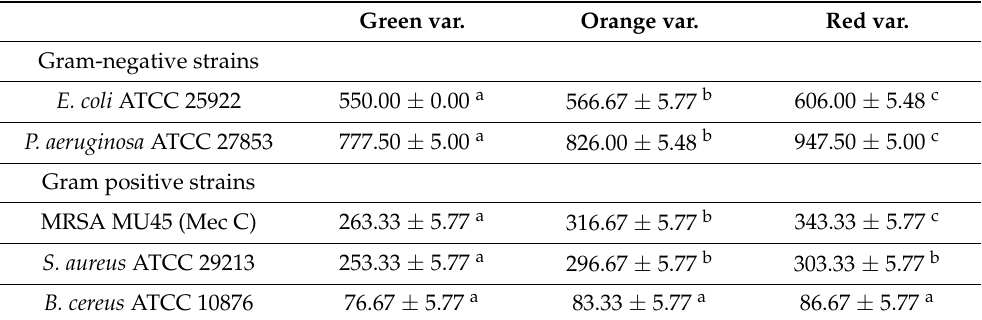
Table 3. Minimal inhibitory Concentrations of Opuntia ficus-indica root lipophilics expressed in ( µ g mL − 1 ). Green var. Orange var. Red